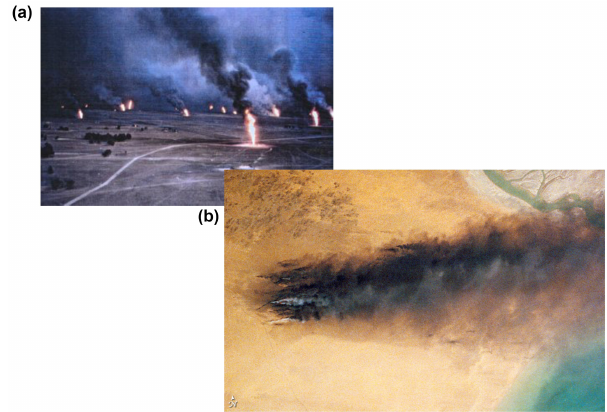
the intensive fires and the rise of plumes due to the heat buoyancy. The lower panel shows the fires were transported east due to winds from the